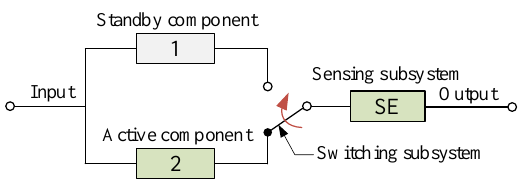
Figure 8. Two-unit standby system with sensing and switching